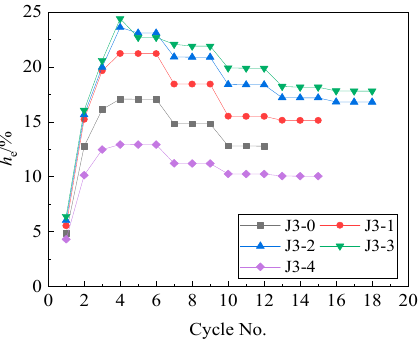
Figure 31. Equivalent viscous damping ratio–cycle no.